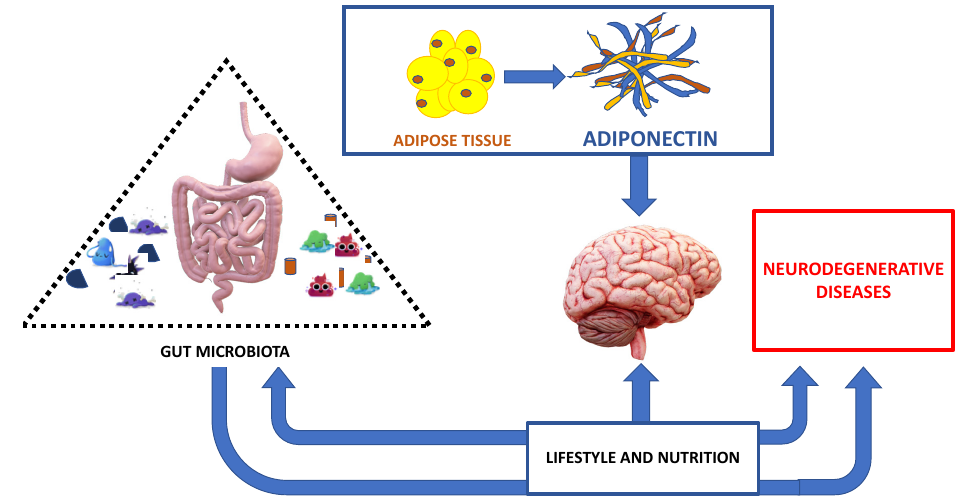
Figure 2. The major interplay between correct nutrition, adipose tissue, gut microbiota and neurodegenerative diseases.